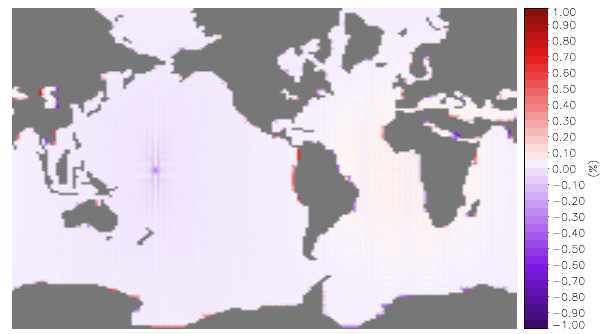
Fig. 7. Relative error obtained (in %) with the conservative remap- ping from the ORCA2 grid to the LMDz.